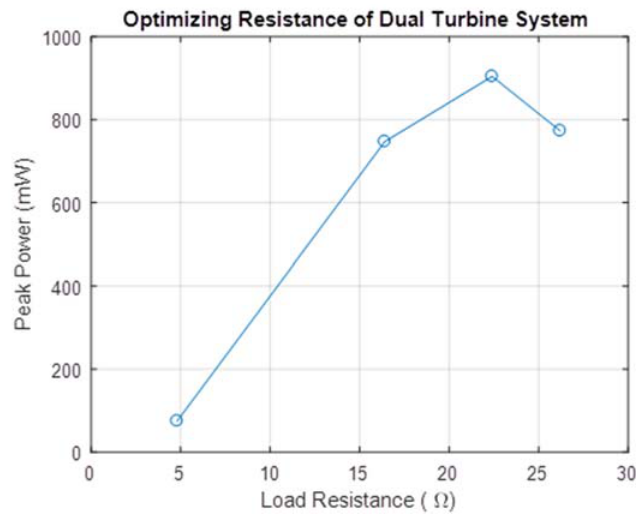
Figure 5. Peak power output versus values of load resistance.